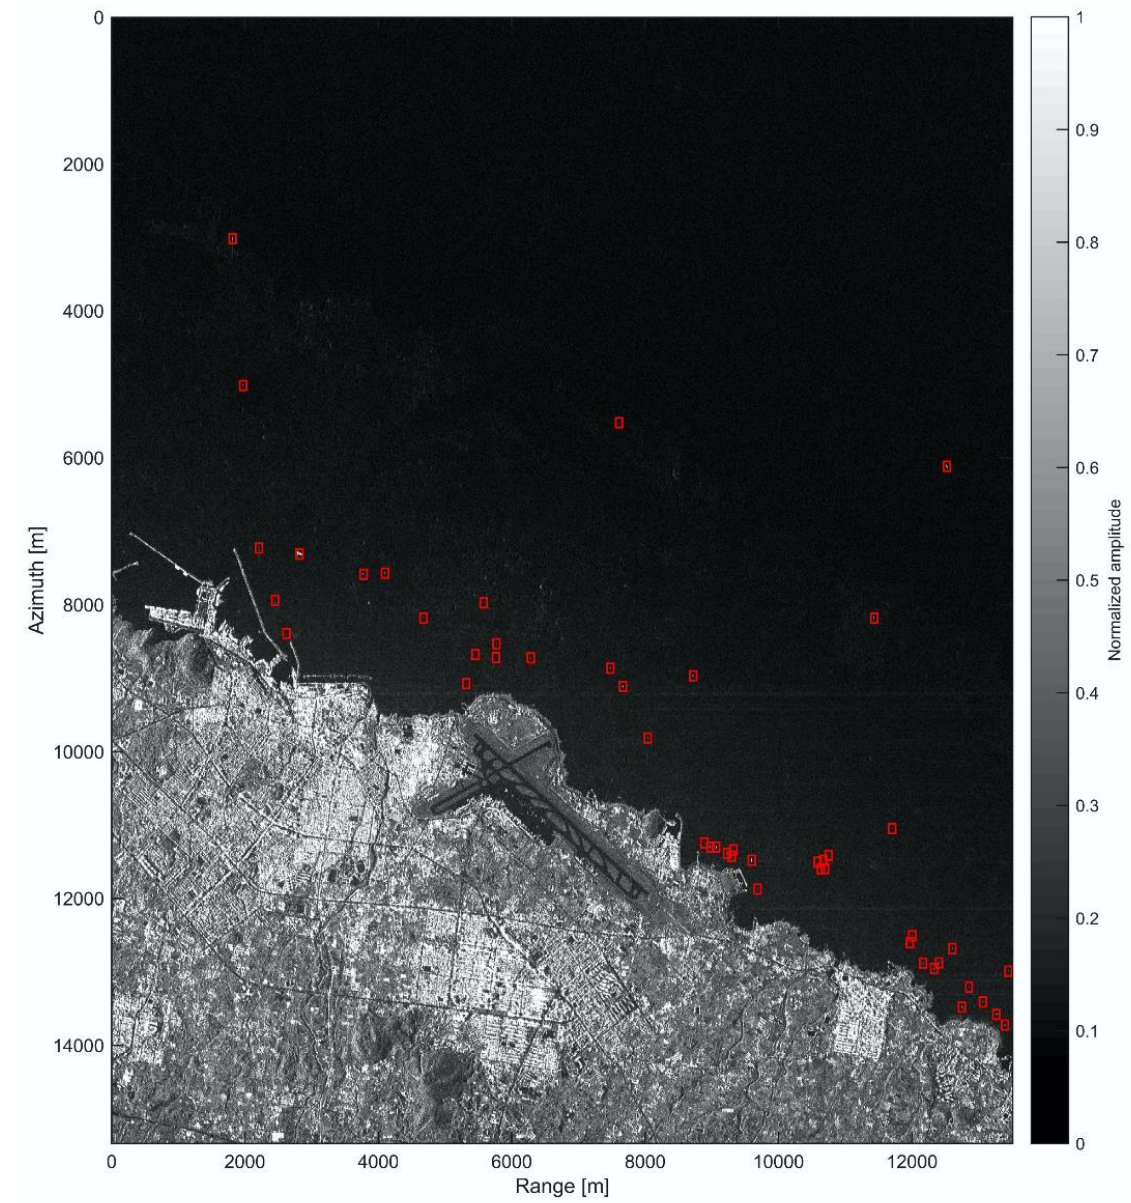
Figure 8. Final result obtained by the proposed method for the test image presented in Figure 2. Compared with the original SLC image presented in Figure 2, most ghost targets are very effectively suppressed, and the resulting image could be used for the efficient detection of vessels or bottom rocks exposed above the surface in coastal waters.